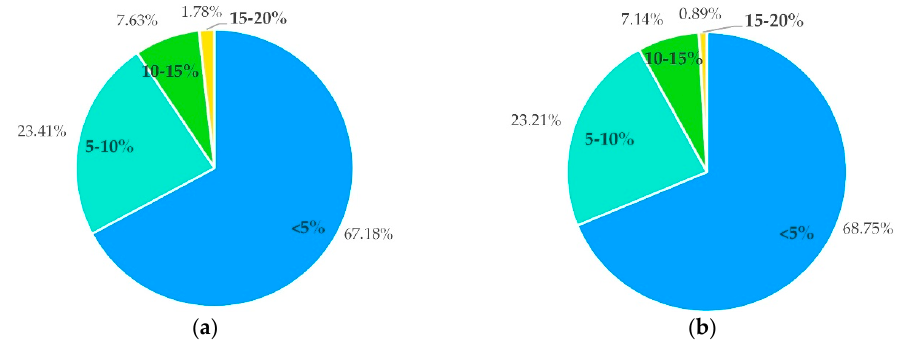
Figure 5. The preferences for an increase in costs, ( a ) for the consumers and ( b ) for the